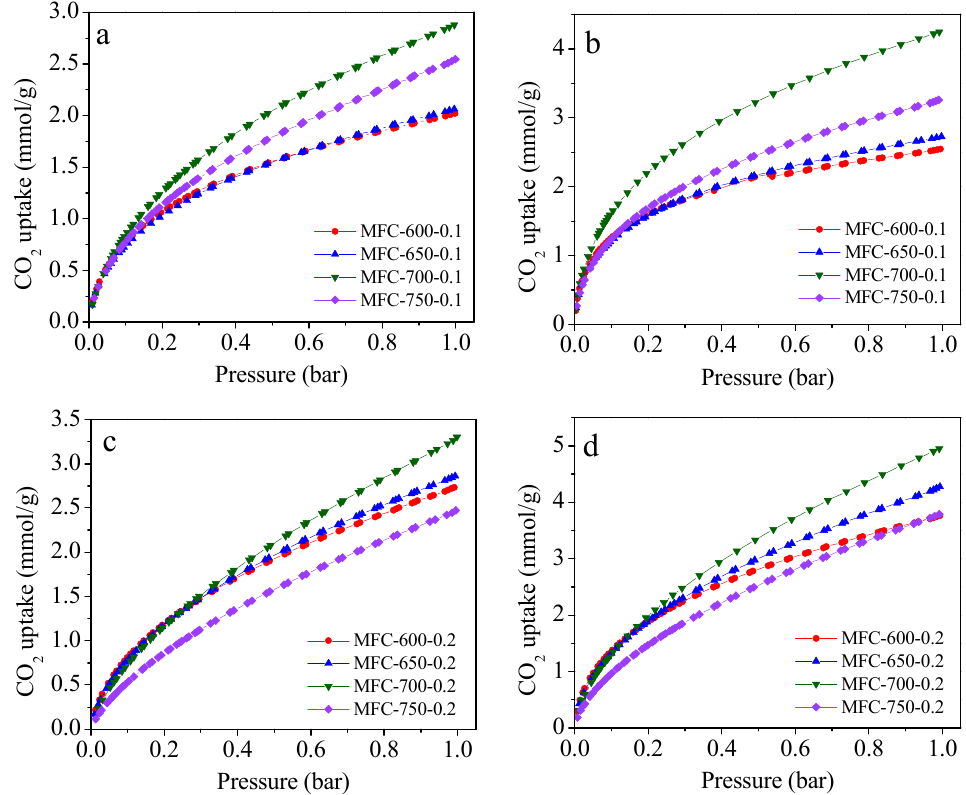
Figure 5. CO 2 adsorption isotherms at 25 °C ( a , c ) and 0 °C ( b , d ) for melamine formaldehyde resin-derived N-doped carbons prepared under different conditions.